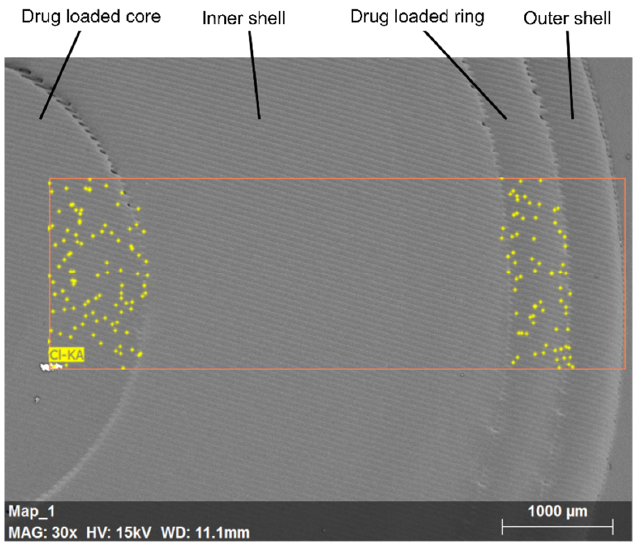
Figure 7. EDX overlap on SEM image of pulsatile release tablets showing localised drug concentration.